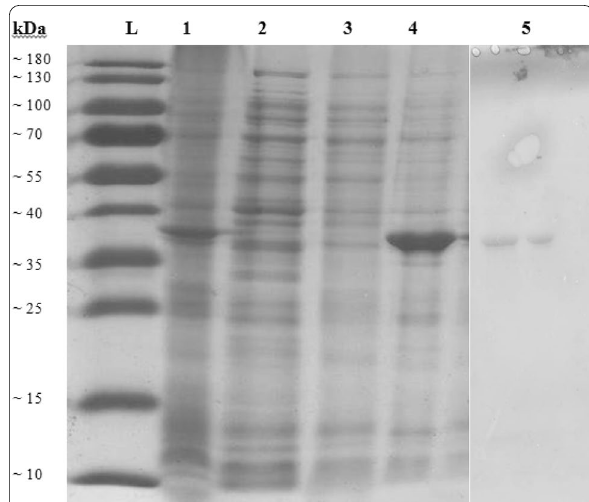
Fig. 3 SDS-PAGE of purified uricase through AOB system. Three fractions including, AOB (lane 1), aqueous phase (lane 2 and 3), and soluble uricase, were resolved on SDS-PAGE. The purified uricase is represented after the first cycle of purification (lane 4) and after three times washing (lane